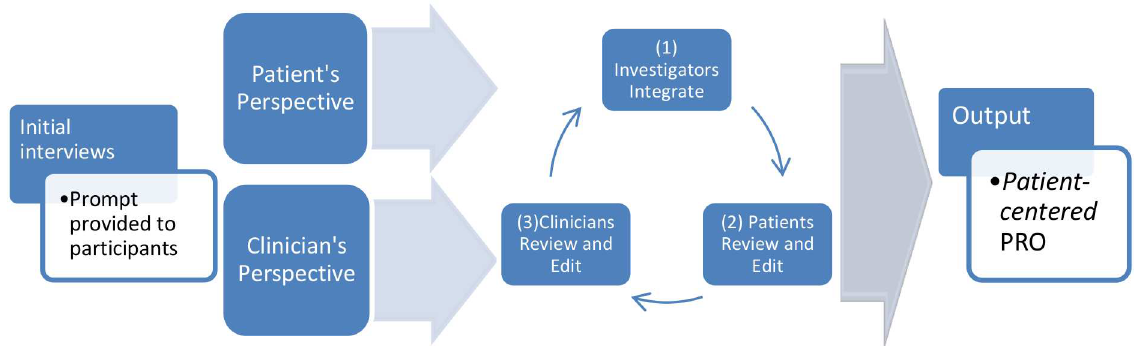
Fig 2. Framework for developing a patient- centered , Patient Reported Outcome